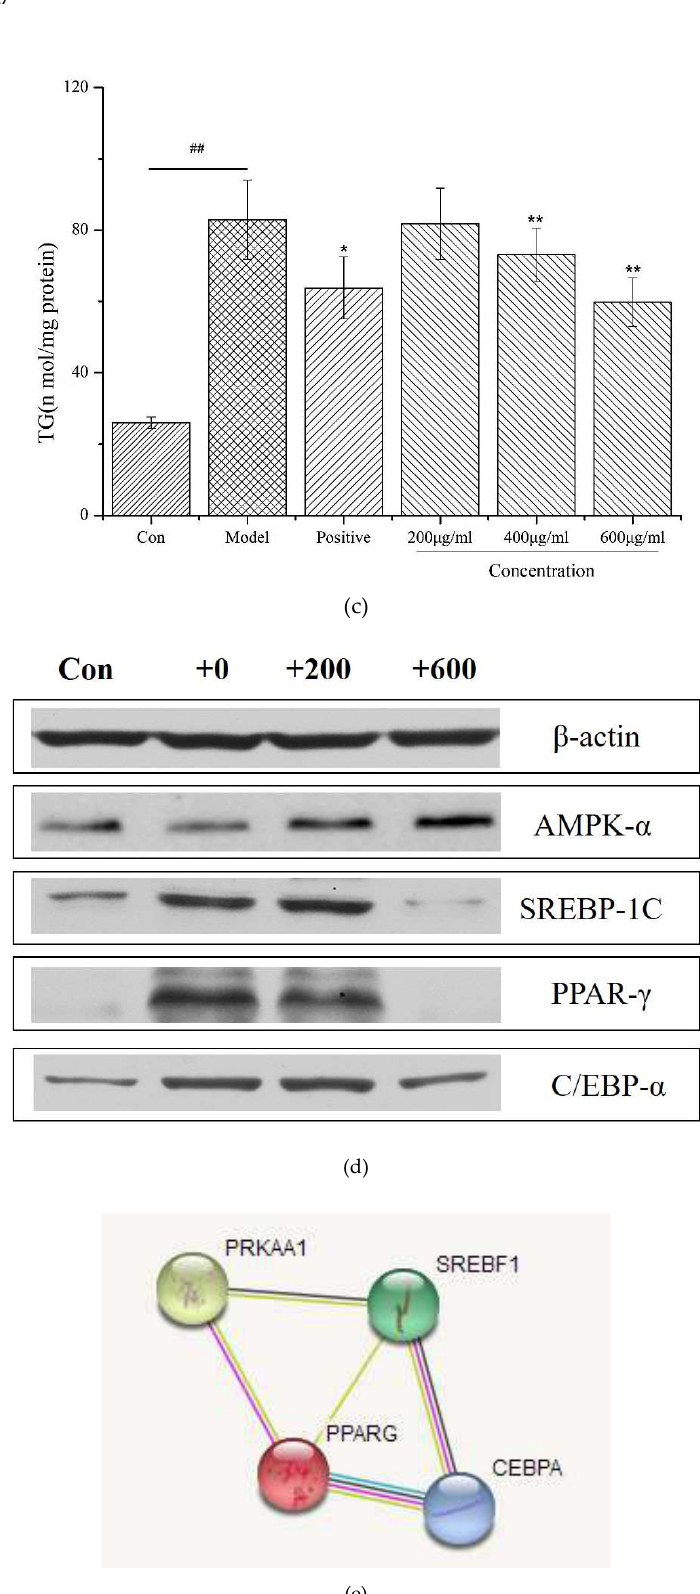
Figure 3. ( a ) The e ff ect of PP1 on 3T3-L1 cell viability. ( b ) Lipid accumulation was determined by Oil Red O. ( c ) PP1 inhibited intracellular lipid accumulation in 3T3-L1 adipocytes, 10 µ M simvastatin was used as a positive group. ( d ) The protein expressions by Western blot. ( e ) The core network mapped by STRING analysis, CEBPA–C / EBP α , SREBF1–SREBP-1c, PPARG–PPAR γ , PRKAA1–AMPK α